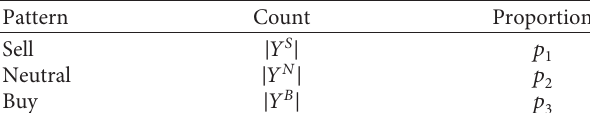
Table 1: Table of pattern counts.